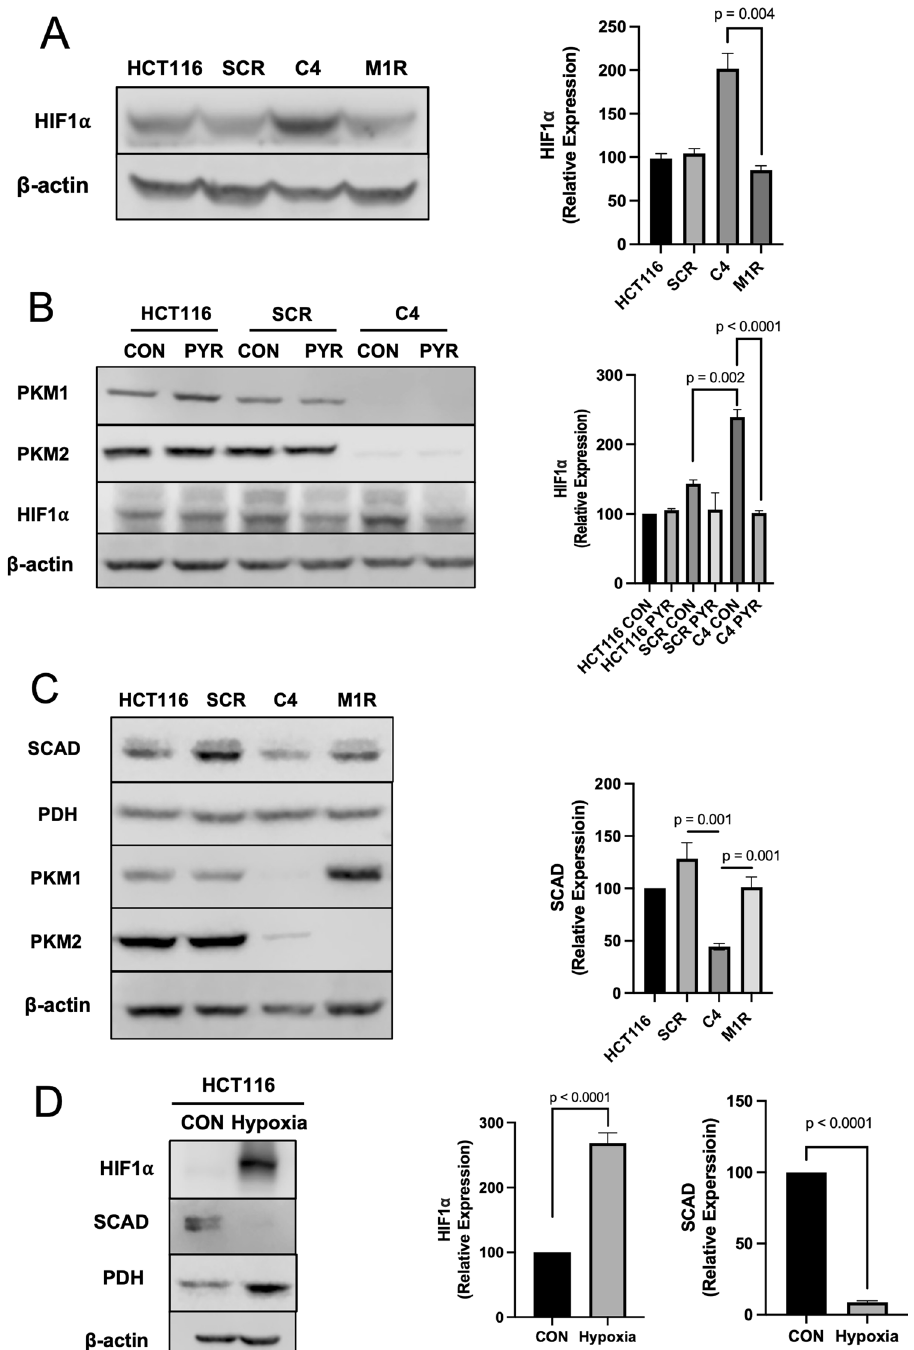
Figure 6. The expression of HIF1α and SCAD is affected by PKM1. ( A ) Western blot analysis of HIF1α levels in HCT116, SCR, C4, and M1R cells with β-actin as a loading control. The right panel shows the quantification of HIF1a expression. ( B ) Western blot analysis of HIF1α levels in HCT116, SCR, and C4 cells treated with and without pyruvate (5 mM). β-actin served as a loading control. ( C ) Western blot analysis of SCAD levels in HCT116, SCR, C4, and M1R cells with PDH as loading controls. ( D ) Western blot analysis of HIF1α and SCAD levels in HCT116 cells with and without hypoxic conditions for 24 h. β-actin served as loading control for HIF1α, and PDH served as loading control for SCAD. For statistical analysis, western blot was conducted 5 times. Error bars are mean ±